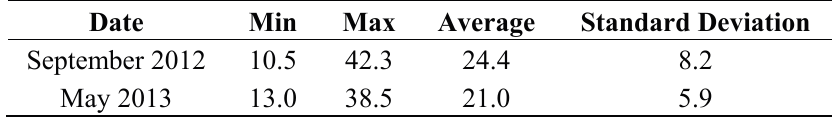
Table 3. Volumetric soil moisture (%) in study